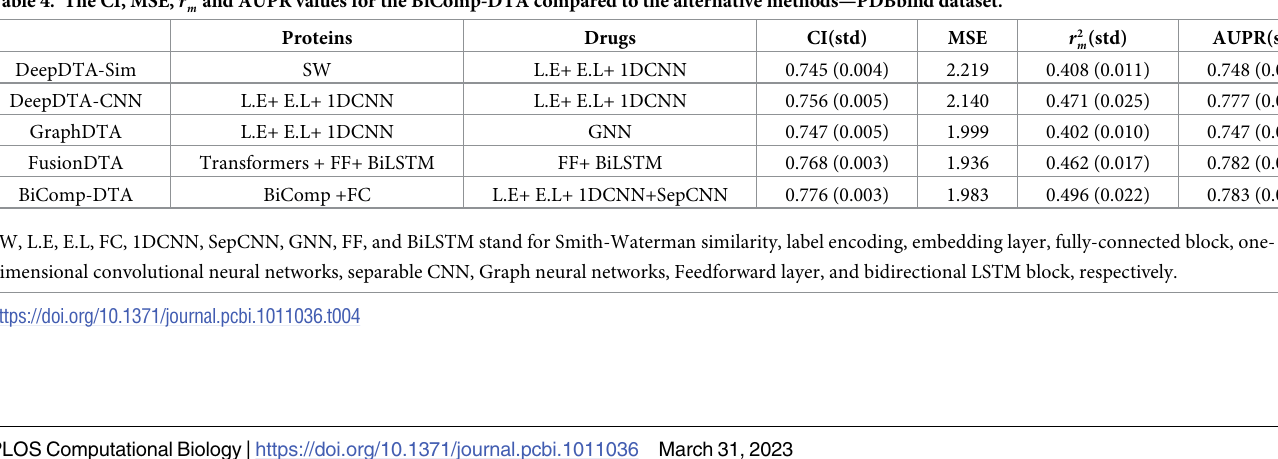
Table 4. The CI, MSE, r 2